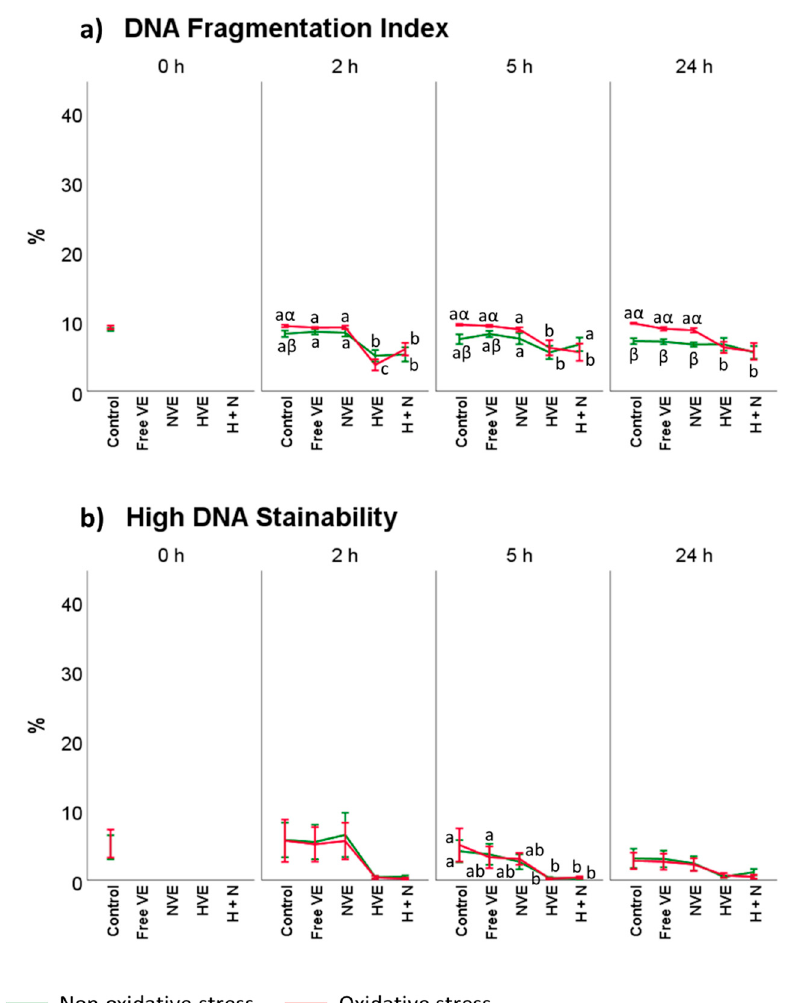
Figure 10. Vitamin E formulation effects on DNA. Plots ( a , b ) represent the triple interaction of different vitamin E treatments × oxidative treatment × incubation time for the flow cytometry analysis of DNA fragmentation index and high DNA stainability (median fluorescence of sperm assessed by SCSA ® ). The various lowercase Latin letters ( p < 0.05) indicate significant differences between vitamin E treatments, while the different Greek letters ( p < 0.05) compare each treatment at the same time with a different oxidative stress status.